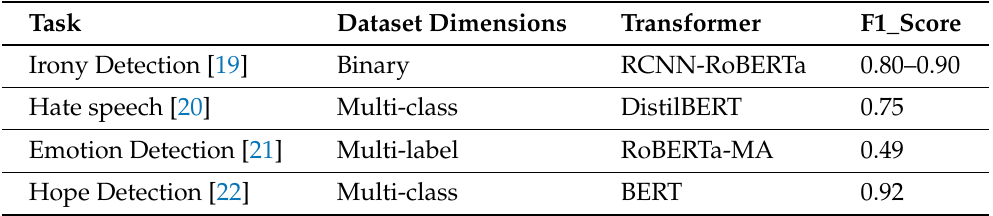
Table 1. The table reports the F1 scores achieved by different transformer methods performing different sentiment-related